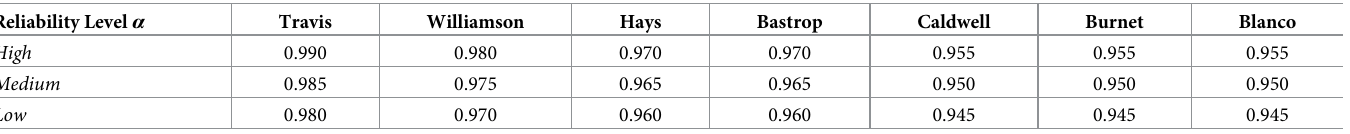
Table 7. Reliability levels for each community used in this